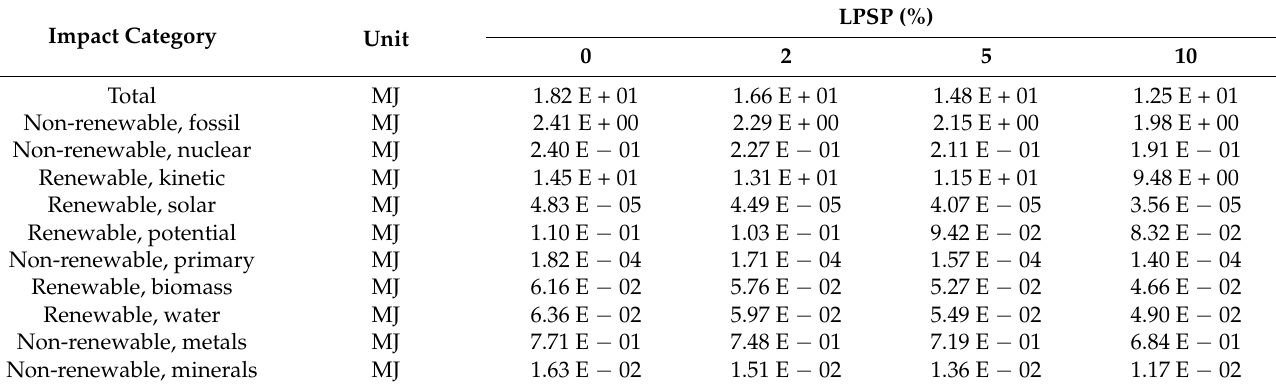
Table 3. CExD for producing 1 m 3 freshwater by SWROD/WT/BBS in various impact categories when the battery is empty. Impact